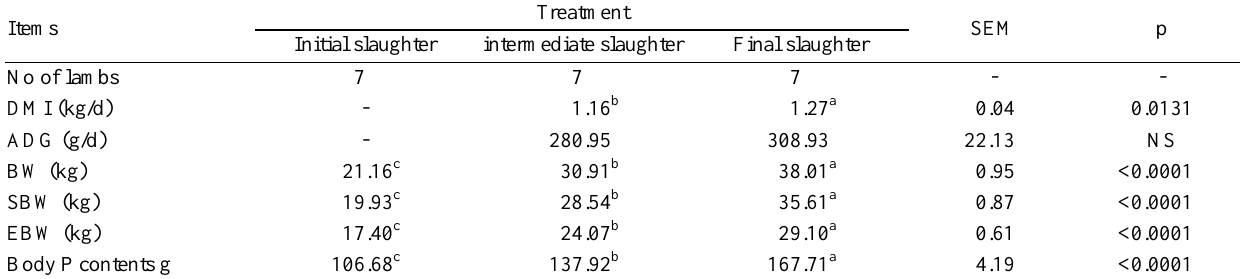
Table 3. DMI and body P composition of Dorper  thin-tailed Han crossbred ram lambs d